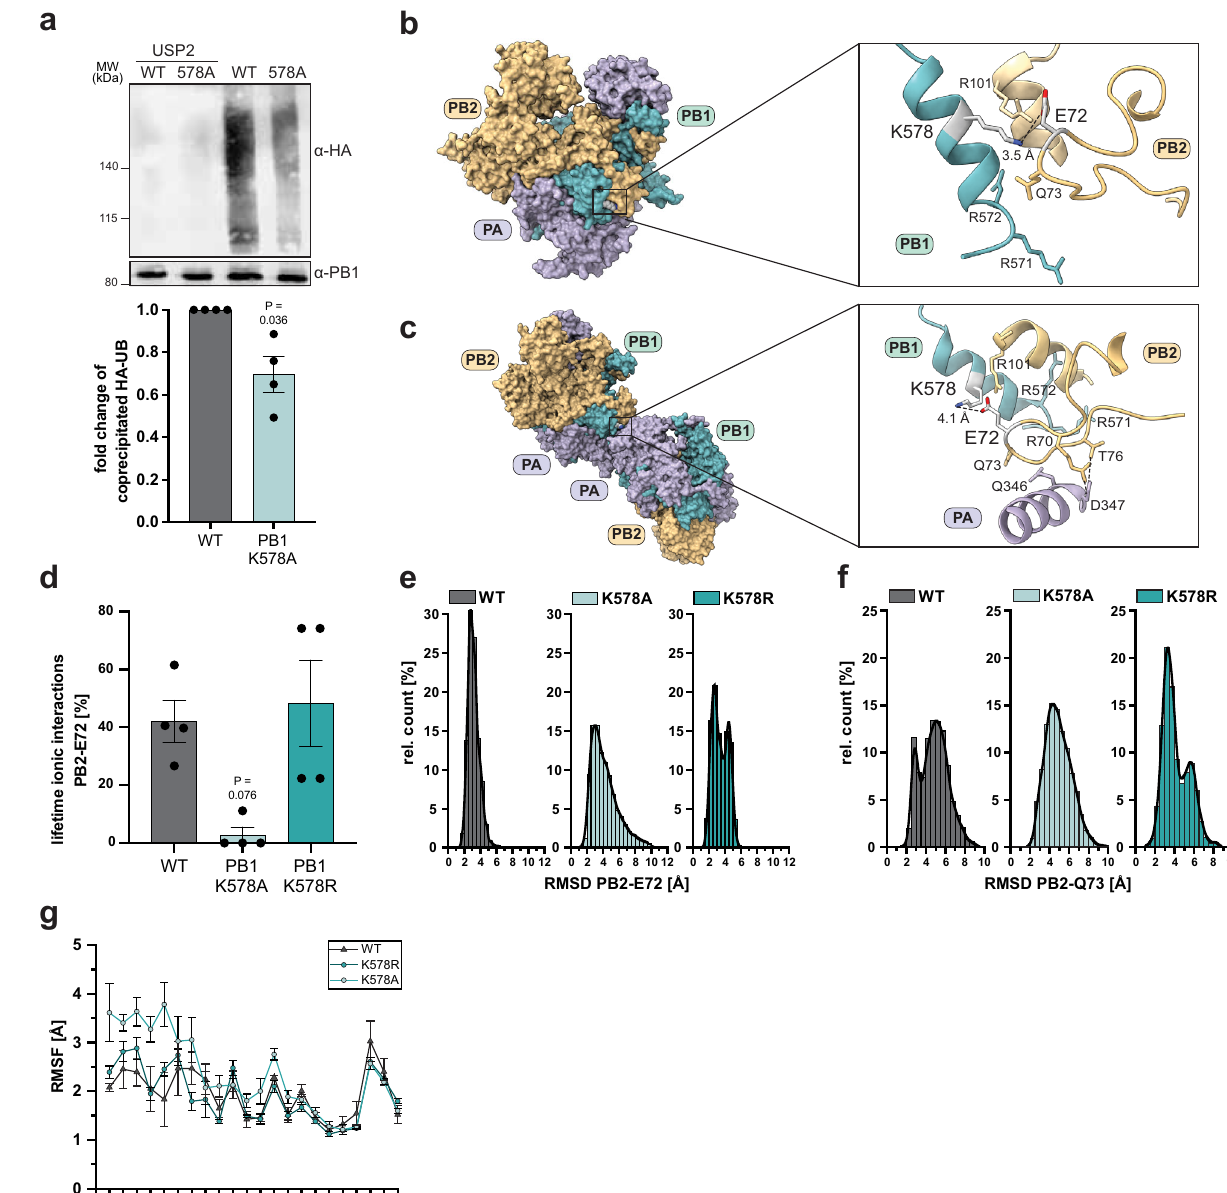
Fig. 4 | PB1-K578 is ubiquitinated and interacts with a loop in the PB2 N-terminus. a A549 cells were co-transfected with strep-tagged PB1 or PB1-K578A and HA-taggedUB.UB-modi fi edPB1subunits werestrep-puri fi edusing denaturing conditions and analyzed by western blot. For de-ubiquitination, bound PB1 con- structs were treated with USP2. Co-precipitated UB-HA levels were quanti fi ed and presented as the mean fold change of WT (±SEM), n =4 independent biological replicates. P values compared to WT from Welch ’ s corrected two-tailed t-test are indicated. b , c Illustration ofPB1-K578 in the 3D structures of the WSNpolymerase (vRNA-boundconformation; b )andthe3Dstructureofthesymmetricdimerofthe H3N2 polymerase (PDB: 6QNW; c ), showing the K578 containing PB1-helix (cyan), the fl exible loop in the PB2 N-terminus (yellow) harboring PB2-E72 and the helix in the PA C-terminus that participates in dimer formation. Distances between PB1-